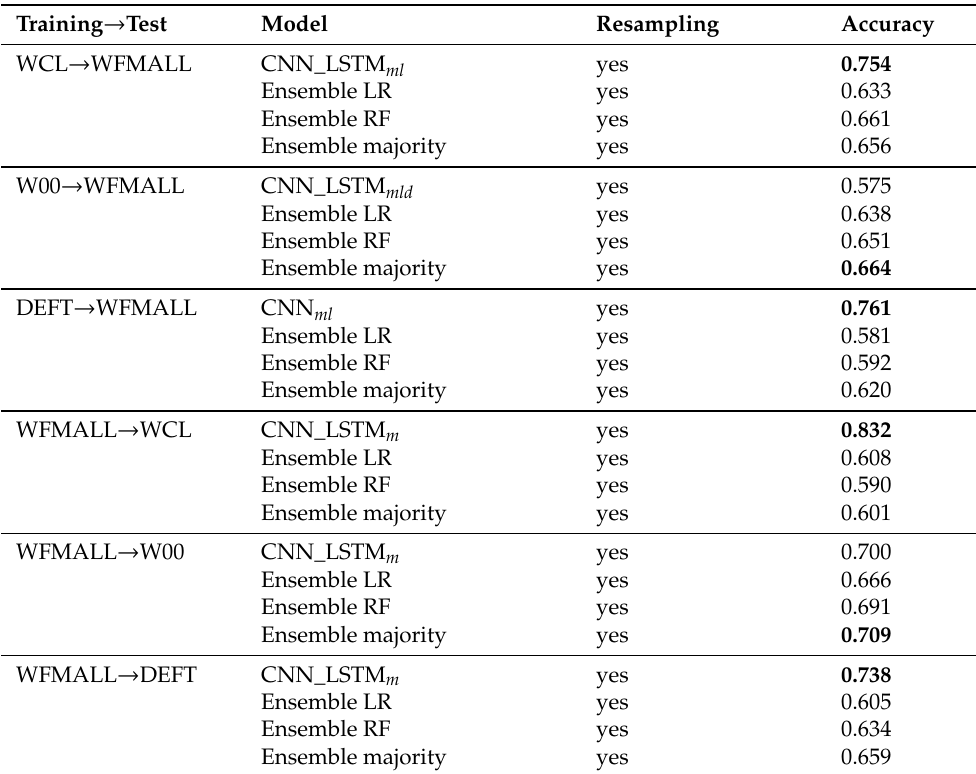
Figure 7. Pipeline of ensemble cross-domain evaluation for X (training) → Y (test) datasets. Table 6. Cross-domain